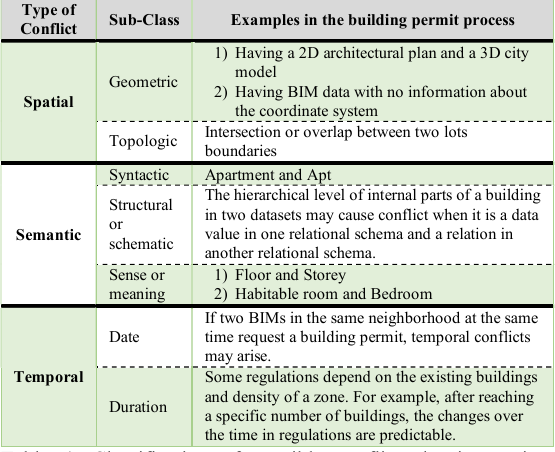
Table 4. Classification of possible conflicts by integrating different sources of information (cid:120) Spatial Conflicts: In the data integration process, the first important part that describes the geometric and topological inconsistencies is considered as spatial conflicts. o Geometric: For spatial conflicts with a geometric aspect, first, position and coordinate systems and second, shape (linked to the dimension of the point 0D, line 1D, surface 2D or polyhedron 3D primitives), size (scale factor), and orientation of the entities should be taken into account. o Topologic: It considers the conflicts that arise based on the interior, boundary, and exterior parts of the objects. Having polygons with non-planar surfaces or having intersection between edges or polygons are some examples of topological conflicts. It should